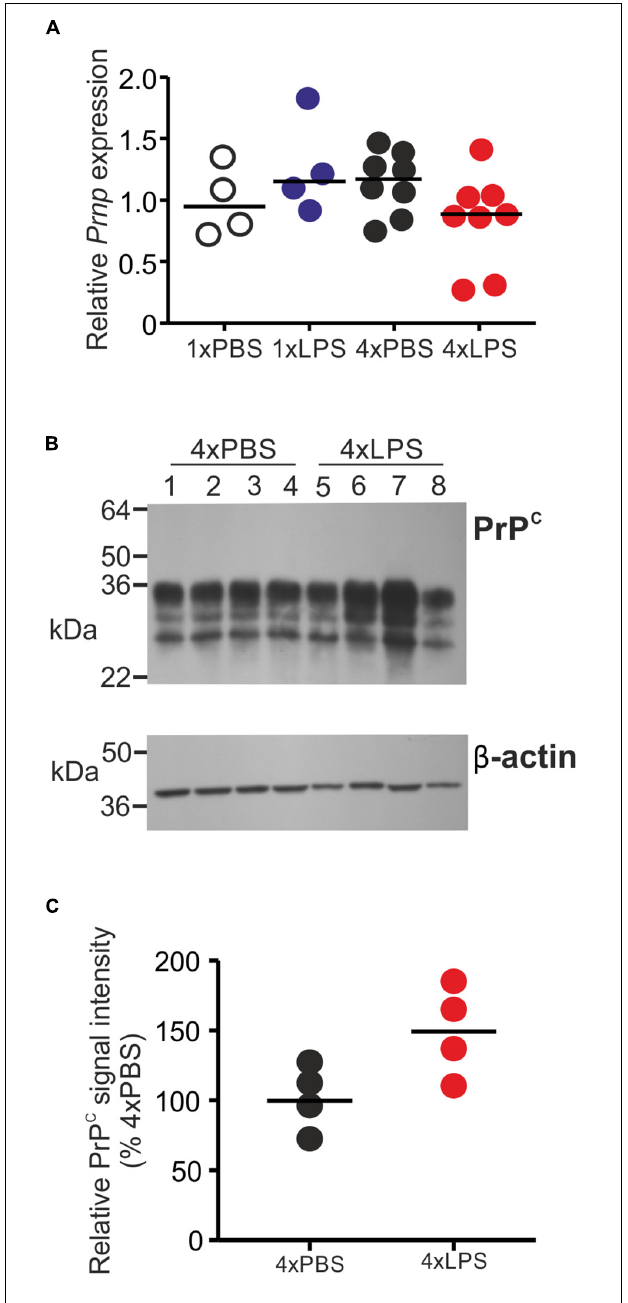
FIGURE 5 | Effect of systemic LPS treatment on PrP C expression in the brain. Mice were given a single (1x) or four (4x) daily IP injections with either LPS or PBS (control) and brains collected 3 h after the final injection. (A) Relative expression level of Prnp mRNA in half brains from each mouse from each group. Gene expression data are normalized so that the mean level in the 1xPBS controls was 1.0. N = 4–8 mice/group. Not significantly different. (B) Western blot analysis of PrP C protein (upper panel) and β -actin (lower panel) in half brains from mice given 4 daily IP injections with either LPS or PBS (4xPBS, 4xLPS, respectively). (C) Quantitation of the relative abundance of PrP C protein in half brains from each group. The abundance of PrP C in each sample was normalized to β -actin and expressed as the% relative to the mean value in the 4xPBS-treated controls. N = 4 mice/group; horizontal bar in histogram, median. Not significantly different, student’s t